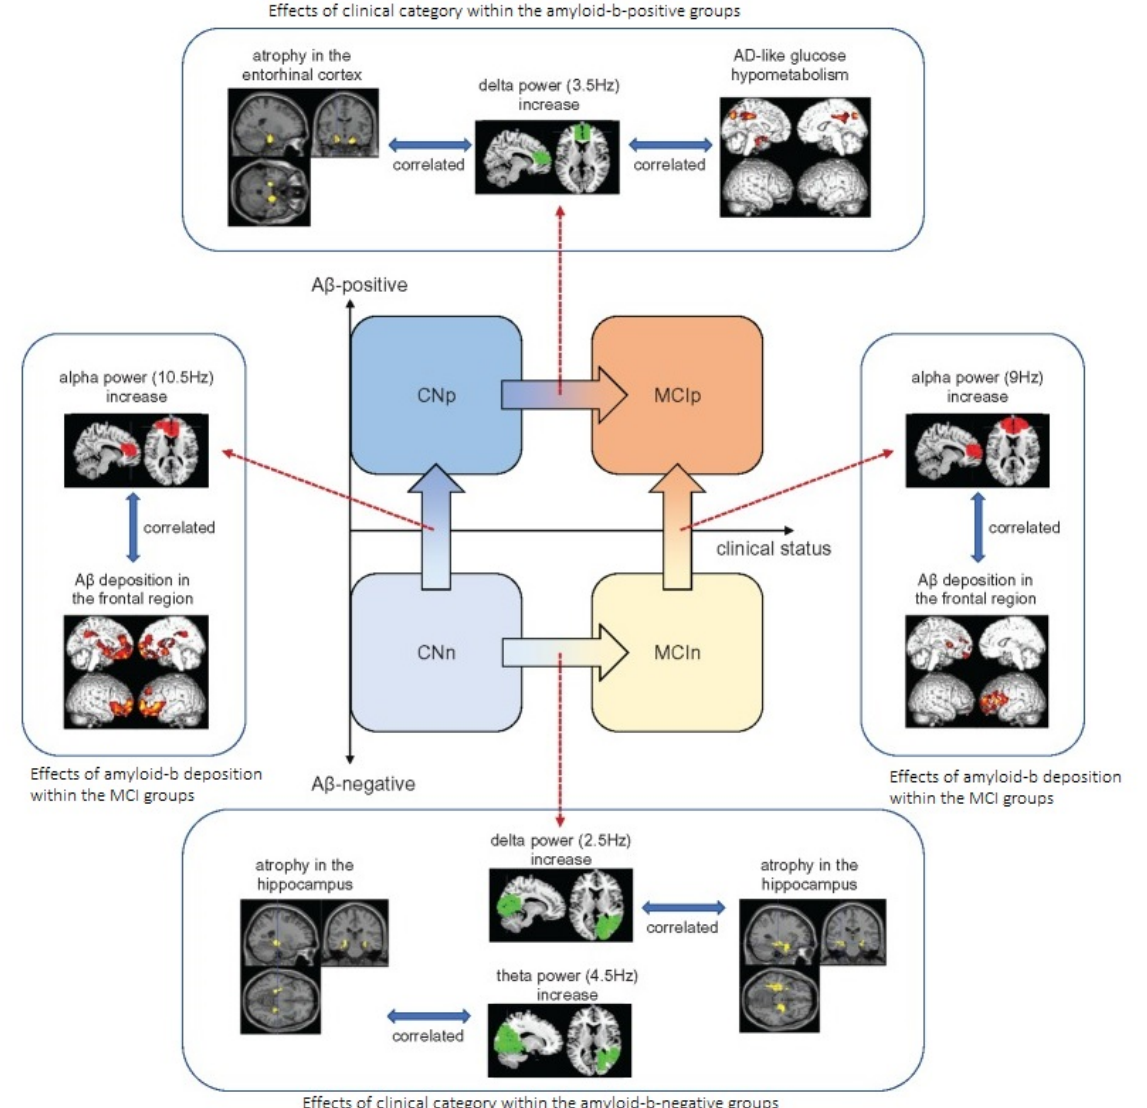
Figure 6. The characteristics of the MEG power markers. The arrows with the gradation colors indicate the directions where the relative power increases (not indicating clinical transition). Reprinted from [76]. (Copyright 2018 Oxford University Press) Image reproduced as per terms of CC BY-NC 4.0